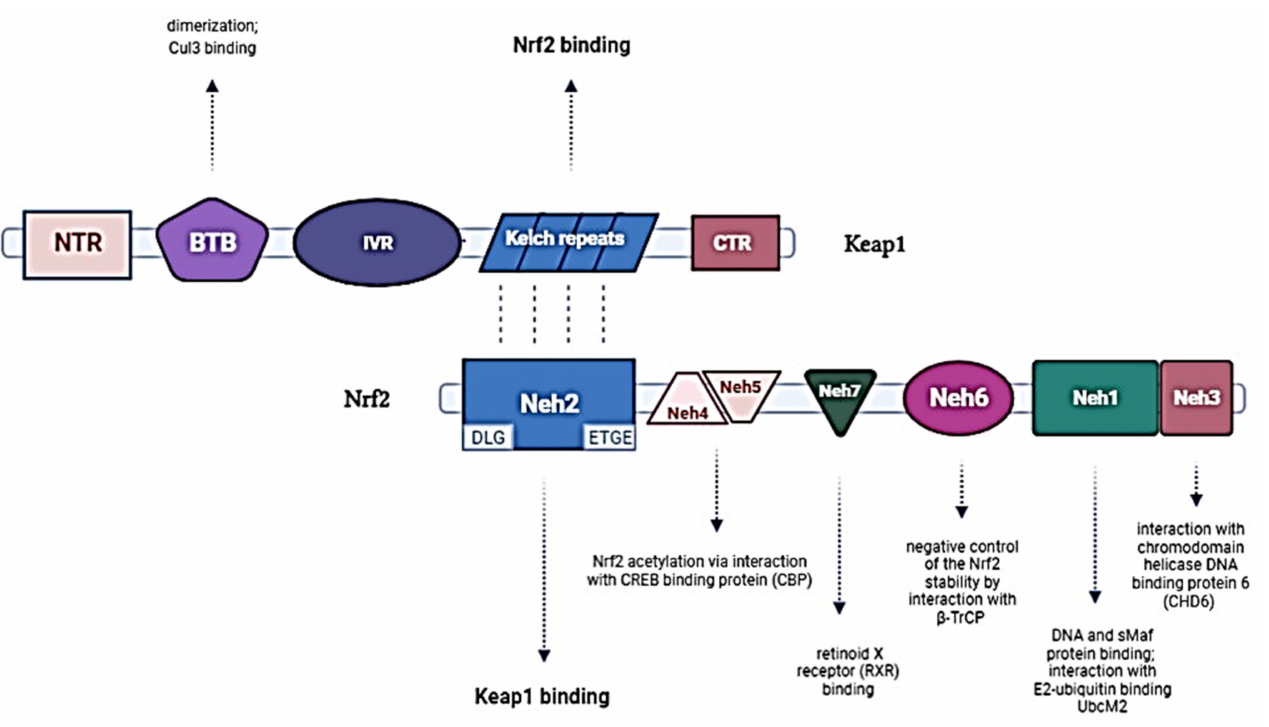
Figure 2. Domain structures of the Keap1 and Nrf2 proteins and their interactions. Keap1 possesses five domains: amino terminal region (NTR), a broad complex, tramtrack, bric-a-brac (BTB) domain, an intervening region (IVR), six Kelch domains, and the C-Terminal Region (CTR). The BTB domain homodimerizes with Keap1 and contributes to the interaction of IVR with Cul3/RBX1 complex. The Kelch domain and CTR mediate the interaction with Nrf2. Nrf2 has seven domains: Neh1–Neh7. Neh1 contains a basic leucine zipper (bZip) motif, where the basic region is responsible for DNA binding, and the Zip dimerizes with other binding partners such as sMAFs. Neh2 contains ETGE and DLG motifs, which are required for the interaction with Keap1. Neh3, 4, and 5 domains are transactivation domains of Nrf2. Neh4 and 5 domains interact with CREB binding protein (CBP). Neh6 contains two β TrCP degrons DSGIS and DSAPGS that are responsible for the β -TrCP-mediated proteasomal degradation. Neh 7 mediates interaction with retinoic X receptor alpha (RXR α ), which represses Nrf2